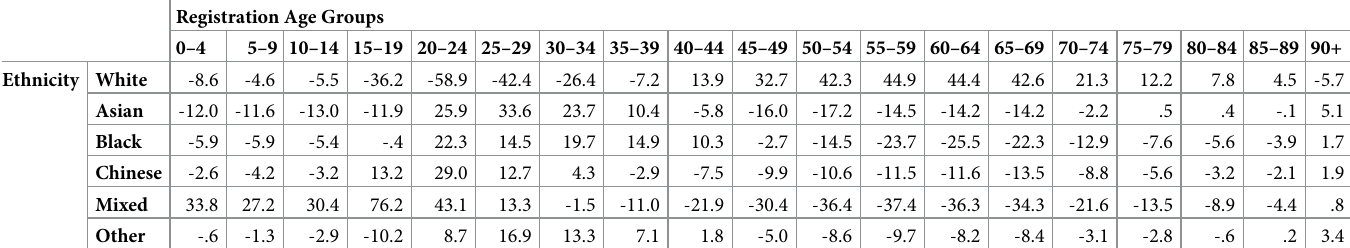
Table 8. Chi 2 test of independence adjusted residuals for registration age group and ethnicity (analysed using dataset 2 –April 2015). Registration Age Groups